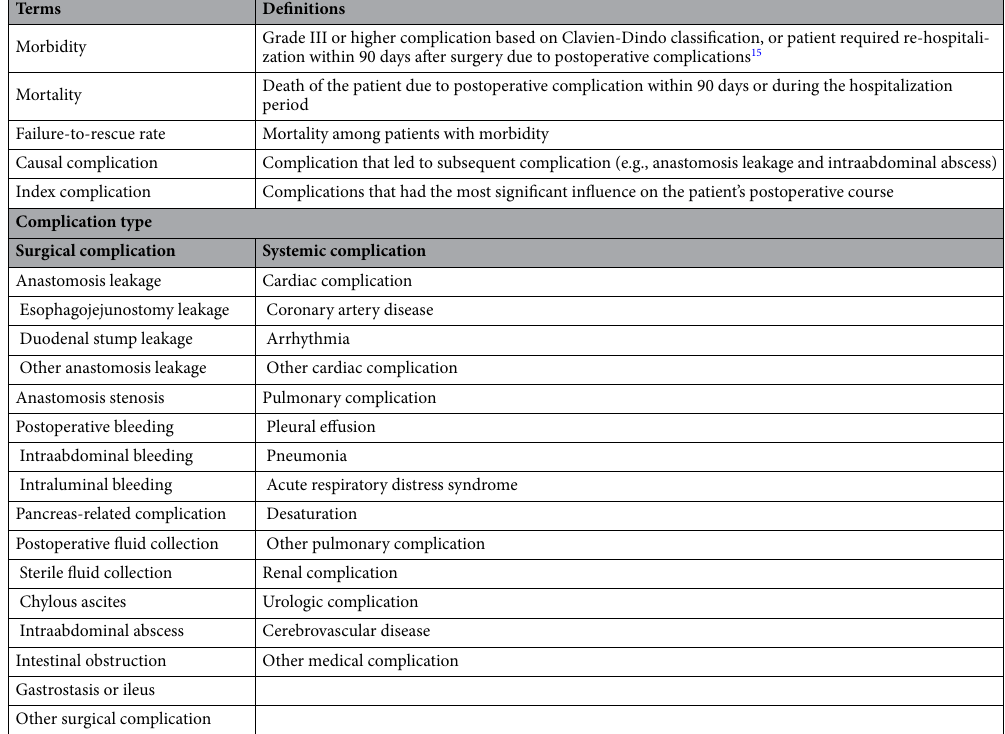
Table 1. Definitions of morbidity, mortality, failure to rescue (FTR), and index complication with a list of complication